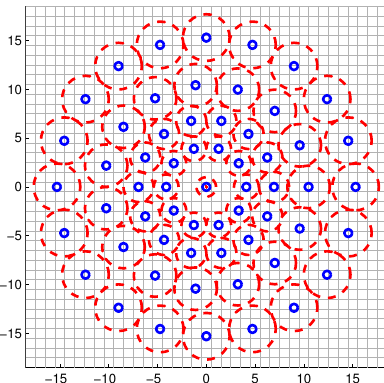
Figure 3: The sampling pattern used to estimate the orientation of a keypoint and to generate the descriptor. The blue circles are the centers of the sampling locations, the red circles represent areas filtered using Gaussian smoothing (Leutenegger et al., 2011).